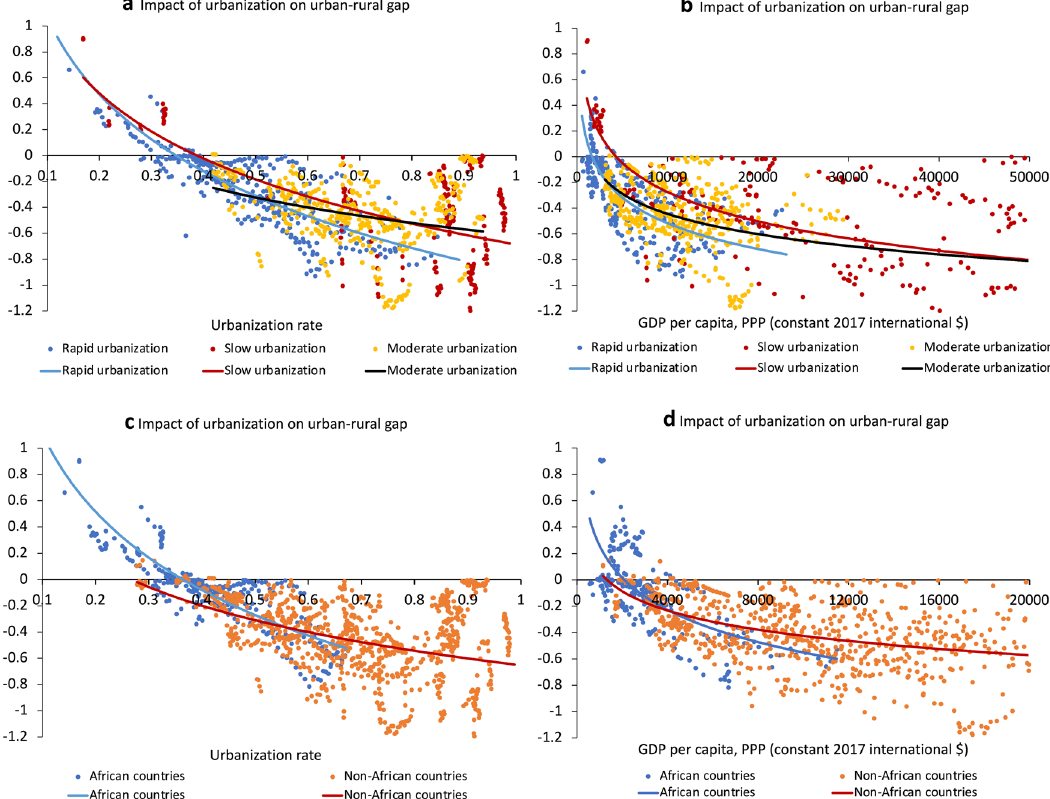
Fig. 6 Impact of urbanization on the urban-rural gap. a The relationship between urbanization rate and impact of urbanization on urban- rural gap in countries with a different urbanization pace. b The relationship between GDP per capita and impact of urbanization on urban- rural gap in countries with a different urbanization pace. c The relationship between urbanization rate and impact of urbanization on urban- rural gap in 30 African countries and 60 non-African countries. d The relationship between GDP per capita and impact of urbanization on urban-rural gap in 30 African countries and 60 non-African countries. Note: This plots the marginal impact of urbanization on the urban-rural gap using 1990 – 2017 data from 90 economies. The pace of urbanization is measured by the growth rate of urbanization (the average annual rate of change of the percentage of urban population). From 1990 to 2017, the median growth rate of urbanization was 1.2% on the high end in Africa, and 0.2% on the low end in Europe and Northern America. Here, we de fi ne rapid-urbanization, slow-urbanization, and moderate- urbanization as having an annual growth rate of urbanization larger than 1.2%, smaller than 0.2%, and between 0.2% and 1.2%, respectively (UN, 2019 1 location, and agglomeration economies 8 . Meanwhile, according to urban migration lags behind sectoral growth differentials, the the Kuznets facts or Clark (1967) 9 , when a country takes off, urban-rural gap will enlarge. This, ceteris paribus, will lead to a growth largely occurs in the urban sectors of manufacturing and rising national inequality. In contrast, promoting urbanization services, and much less in the rural sector. Consequently, if rural- represents a strategic alternative for developing economies to